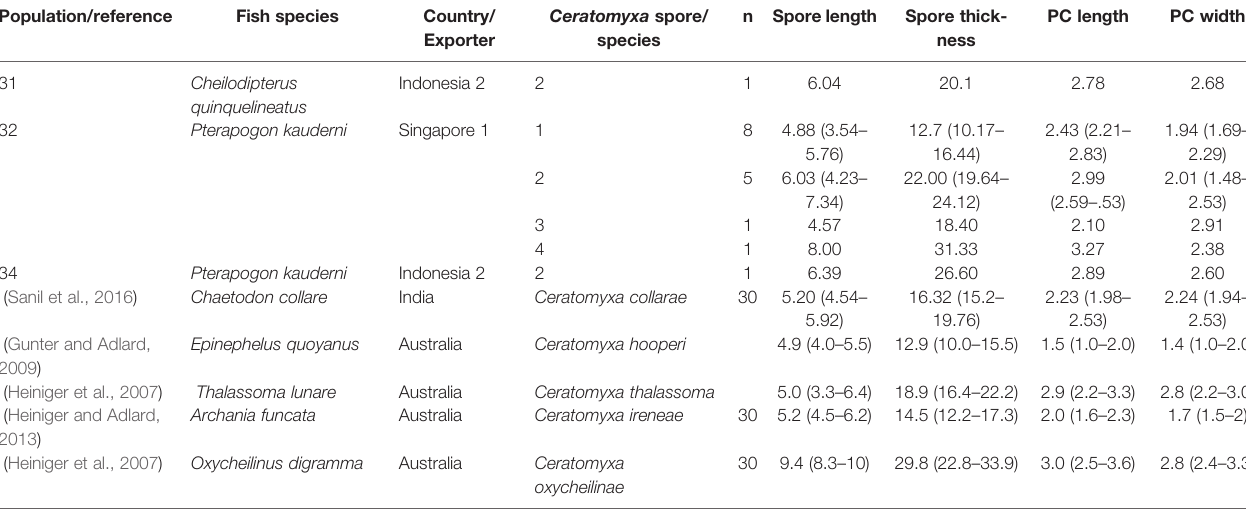
TABLE 4 | Measurements from Ceratomyxa spores found infecting the gall bladder of marine fi sh imported to Australia and comparison to similar Ceratomyxa species.